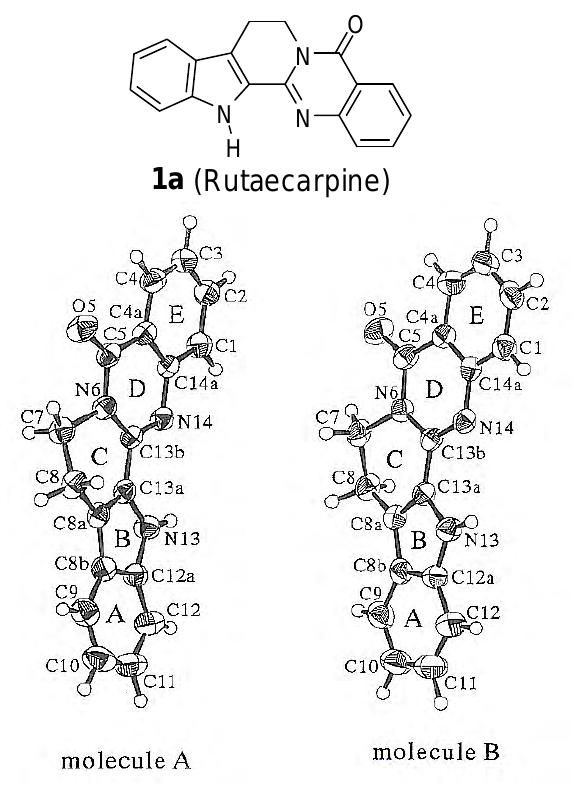
Figure 1 . Structure and two forms of rutaecarpine molecules with numbering